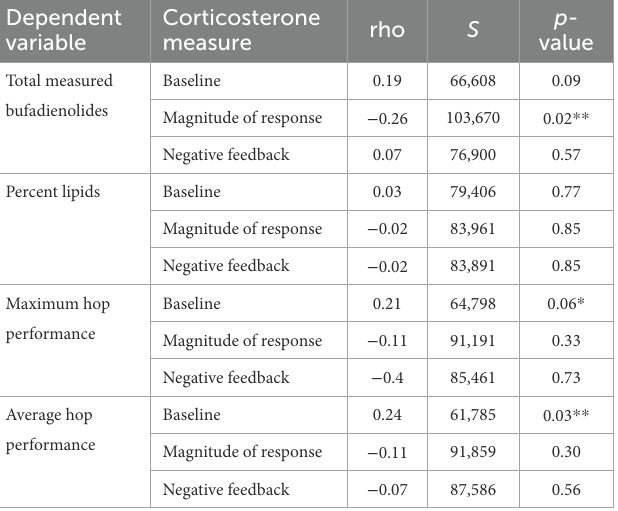
TABLE 7 Spearman’s correlations of corticosterone measurements with other dependent